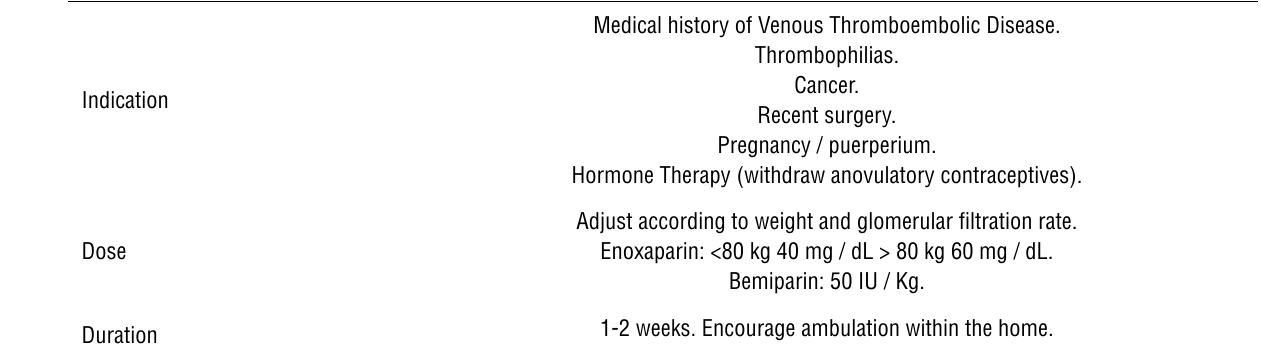
Table 6 - Spanish Society of Thrombosis and Hemostasis (SETH). Thromboprophylaxis in patients with COVID-19 who do